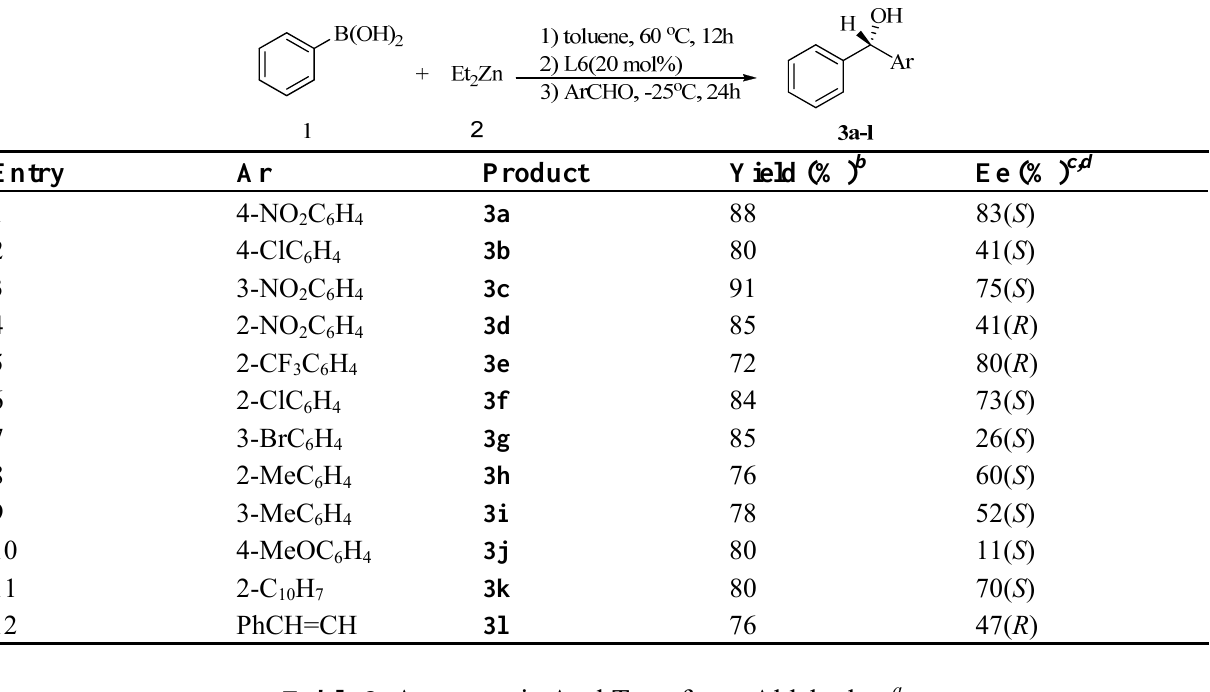
Table 3. Asymmetric Aryl Transfer to Aldehydes .